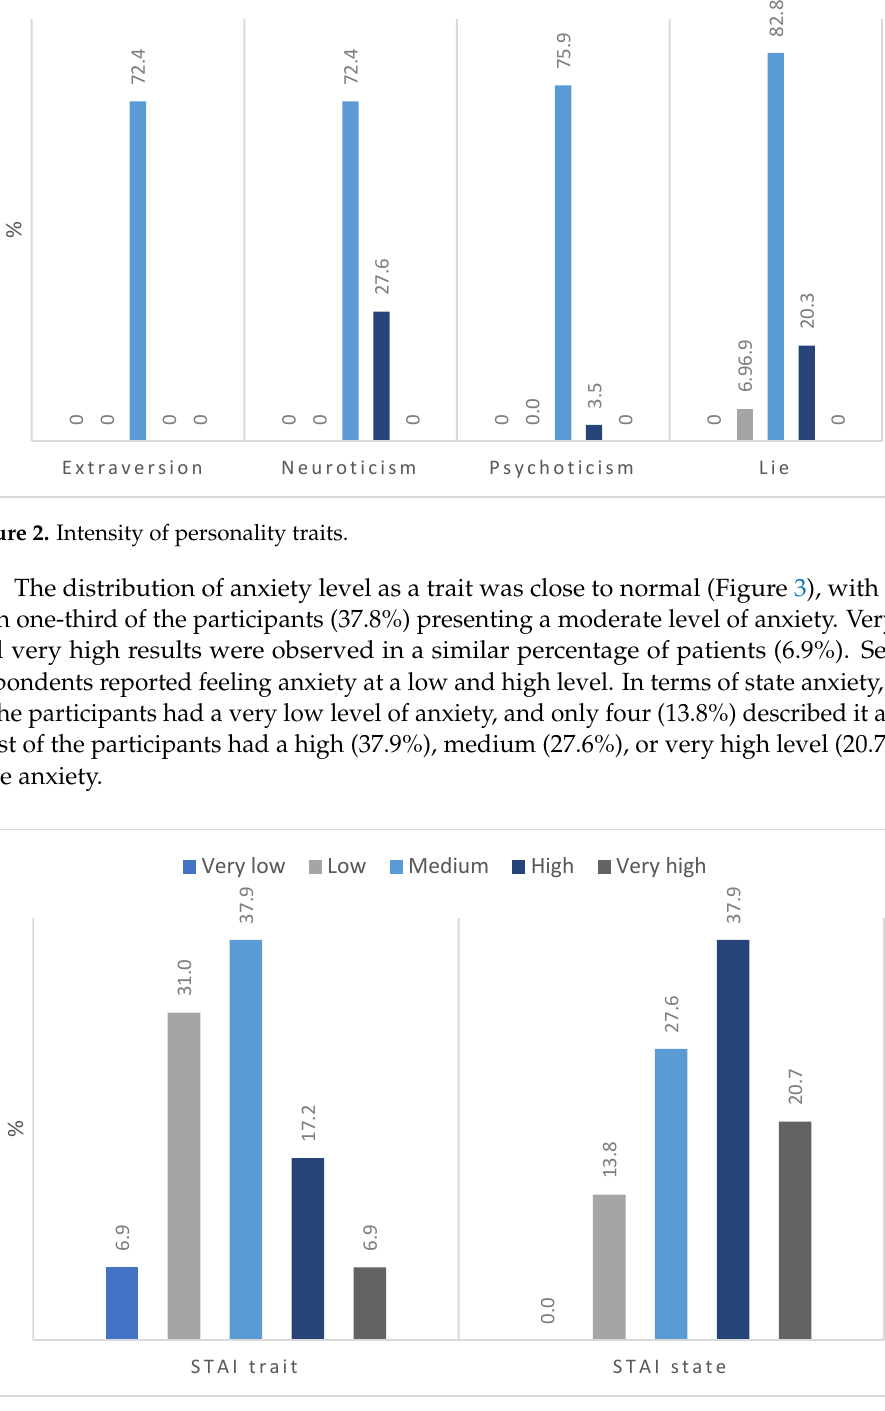
Figure 3. Intensity of anxiety level.